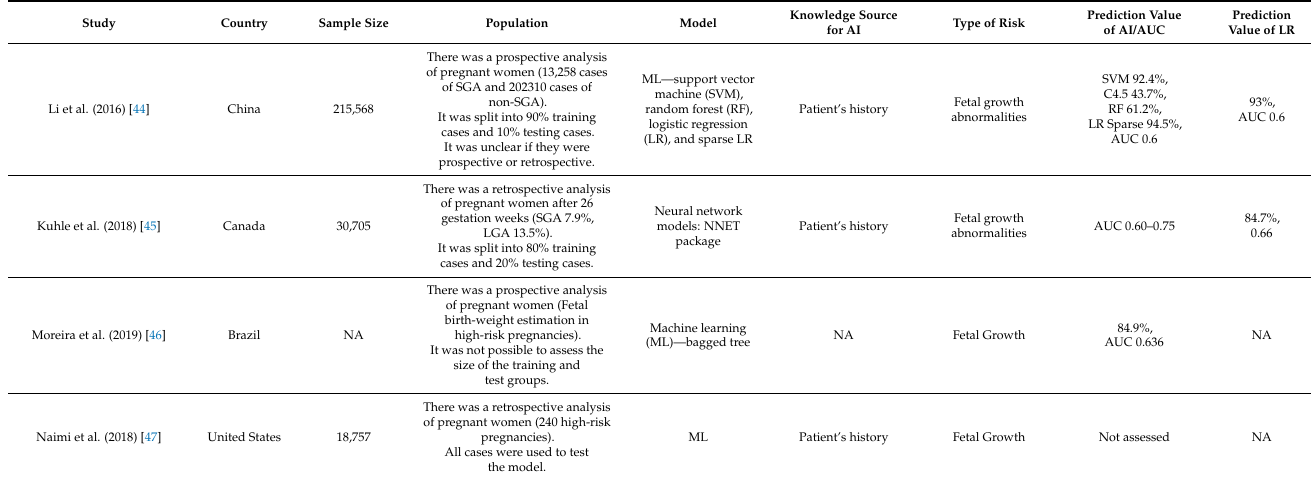
Table 5. Characteristics of included studies on fetal